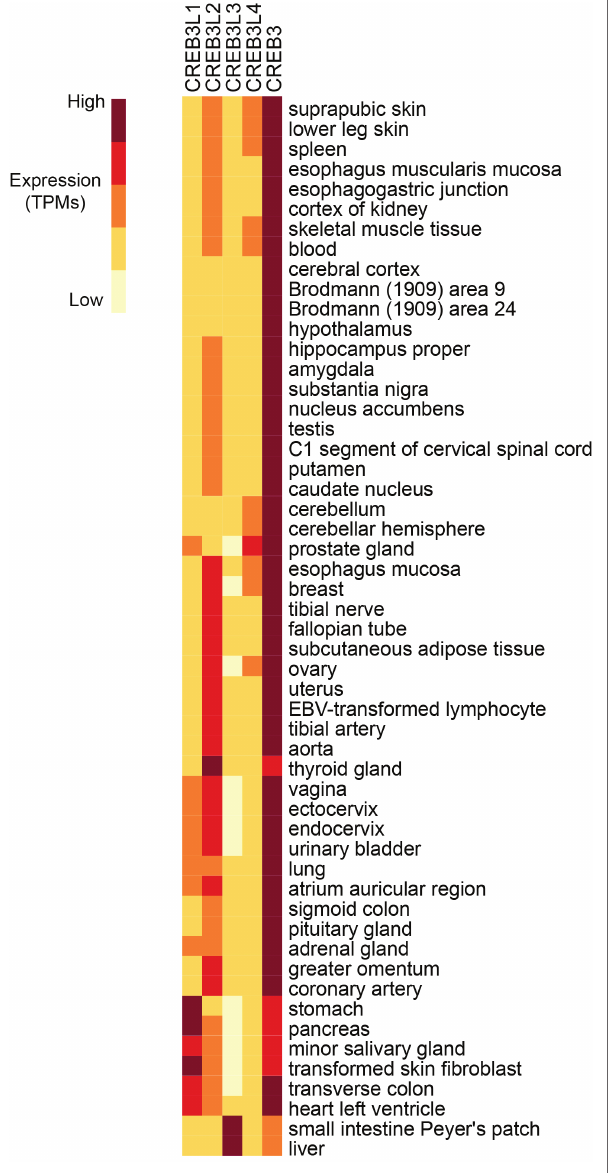
FIGURE 2 | RNA expression analysis of Creb3 transcription factor family across 43 tissues from 175 individual humans (Consortium, 2015). Creb3 is highly expressed in almost all tissues. Creb3L1–4 transcripts are more tissue specific. Creb3L3 is predominantly expressed in prostate glands. Creb3L3 is highly expressed in the small intestine and liver, where it has been shown to regulate metabolism. TPM-normalized data were downloaded from the EMBL-EBI Expression Atlas database (www.ebi.ac.uk) and plotted using